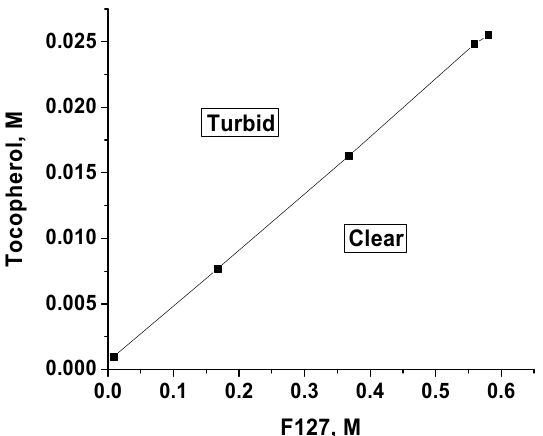
Fig. 5. Titration of solution of F127, SC, drug in PBS with Tocopherol drug and F127 surfactant. The solution is clear below the curve and turbid above the curve.